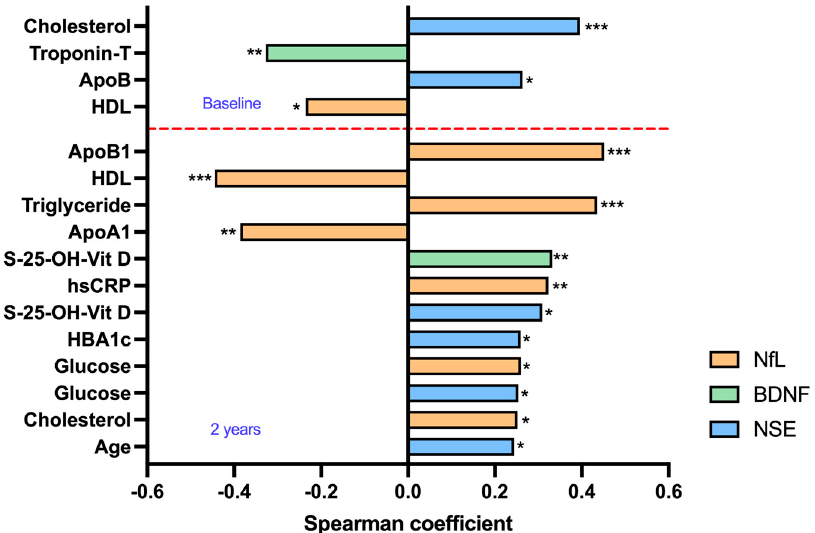
Figure 2. Correlation of biomarkers NfL, BDNF, and NSE with clinical and laboratory parameters in KT patients. * p < 0.05, ** p < 0.01, *** p < 0.001. Abbreviations: Apo-B—apolipoprotein–B; HDL— high density lipoprotein; Apo-A1—apolipoprotein-A1; hsCRP—high sensitivity C-reactive protein; HBA1c—hemoglobin A1c, NfL—neuro fi lament light chain; BDNF—brain-derived neurotrophic factor; NSE—neuron-speci fi c enolase. Red do tt ed lines mark demarcation indicators for baseline and 2 years follow-up.